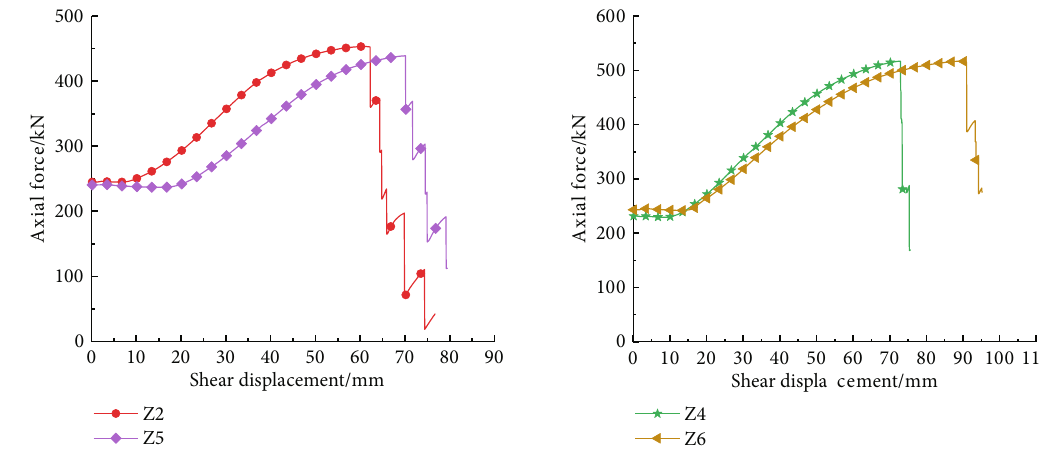
(b) Comparison of Φ 21.8mm ACC and Φ 21.8mm anchor cable Figure 13: Comparison of axial force di ff erences of support component types. Table4: A comparison of the axial bearing performance of supporting members.